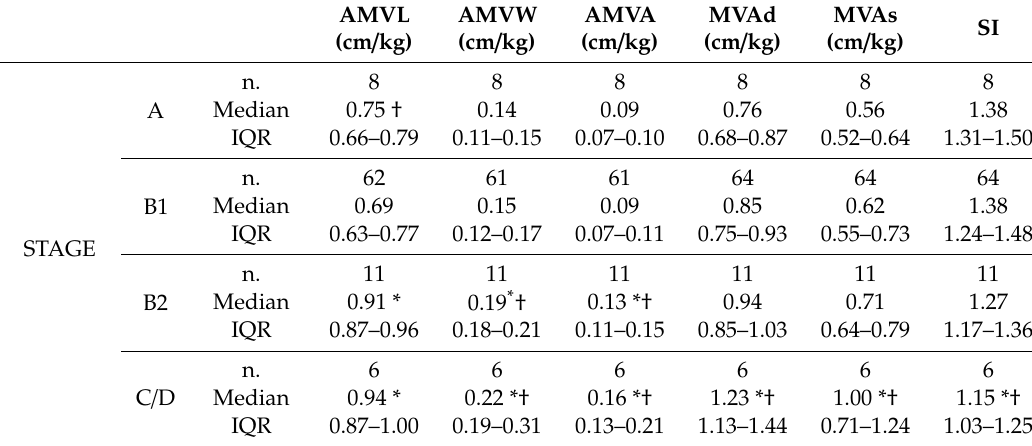
Table 2. Indexed mitral valve measurements of all analyzed subjects related to ACVIM classes. All measurements were indexed to body weight using the scaling exponents calculated by Wesselowski, one for each specific valve measure (Wesselowski et al. 2015). They were, respectively: 0.37, 0.41, 0.78, 0.37 and 0.40 for anterior mitral valve length (AMVL), width (AMVW), area (AMVA), mitral valve annulus in diastole (MVAd) and systole (MVAs). Sphericity index (SI). The variables were not normally distributed and are reported as the median and interquartile ranges (IQR—from 25th to 75th). For n. 1 subject in ACVIM class A was not possible to measure the anterior mitral valve leaflet. * Within a column, values di ff er significantly ( p < 0.01) from ACVIM class B1. † Within a column, values di ff er significantly ( p < 0.01) from ACVIM class